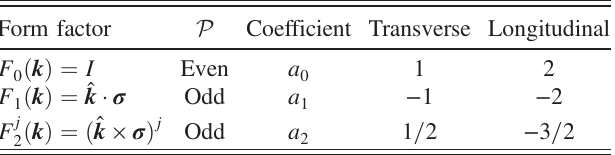
s -wave pairing with J ¼ 0 , while L ¼ 1 states are odd-parity TABLE II. The decomposition of the phonon-mediated inter- actions (30) and (38) into the BCS channels F n with total angular momentum J ¼ 0 ( a 0 and a 1 ) and J ¼ 1 ( a 2 ); see Eqs. (32) and (40). Positive coefficients a i imply the attraction in the corre- sponding BCS